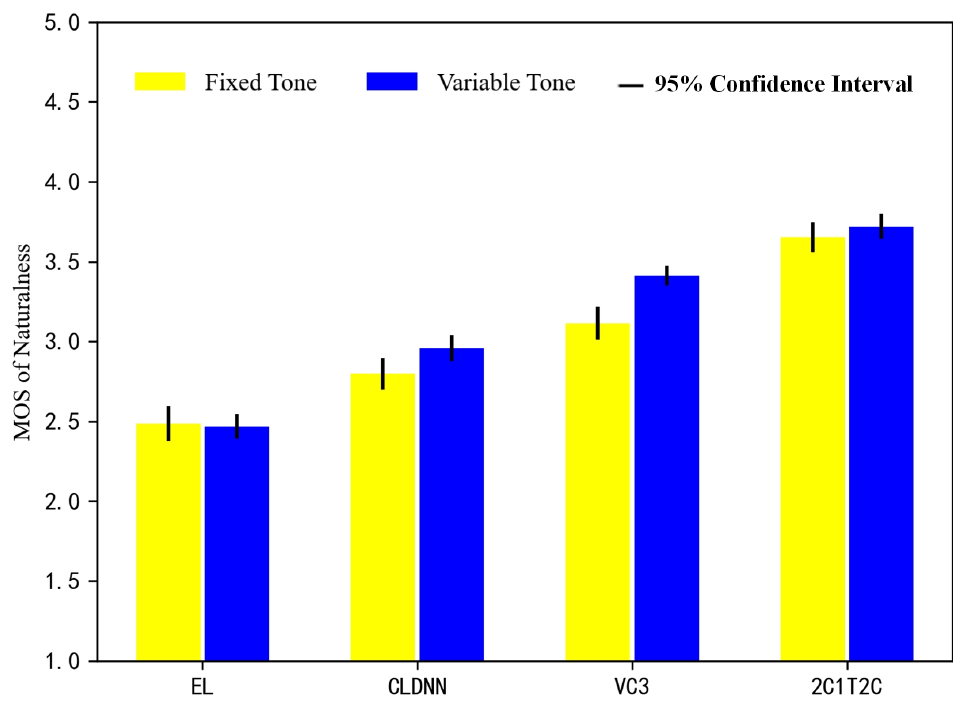
In Figure 5, EL represents the intelligibility MOS of EL − FT and EL − VT; CLDNN rep- resents the intelligibility MOS of CLDNN − FT and CLDNN − VT; VC3 represents the intel- ligibility MOS of VC3 − FT and VC3 − VT; and 2C1T2C represents the intelligibility MOS of 2C1T2C − FT and 2C1T2C − VT. The confidence interval here is 95%.